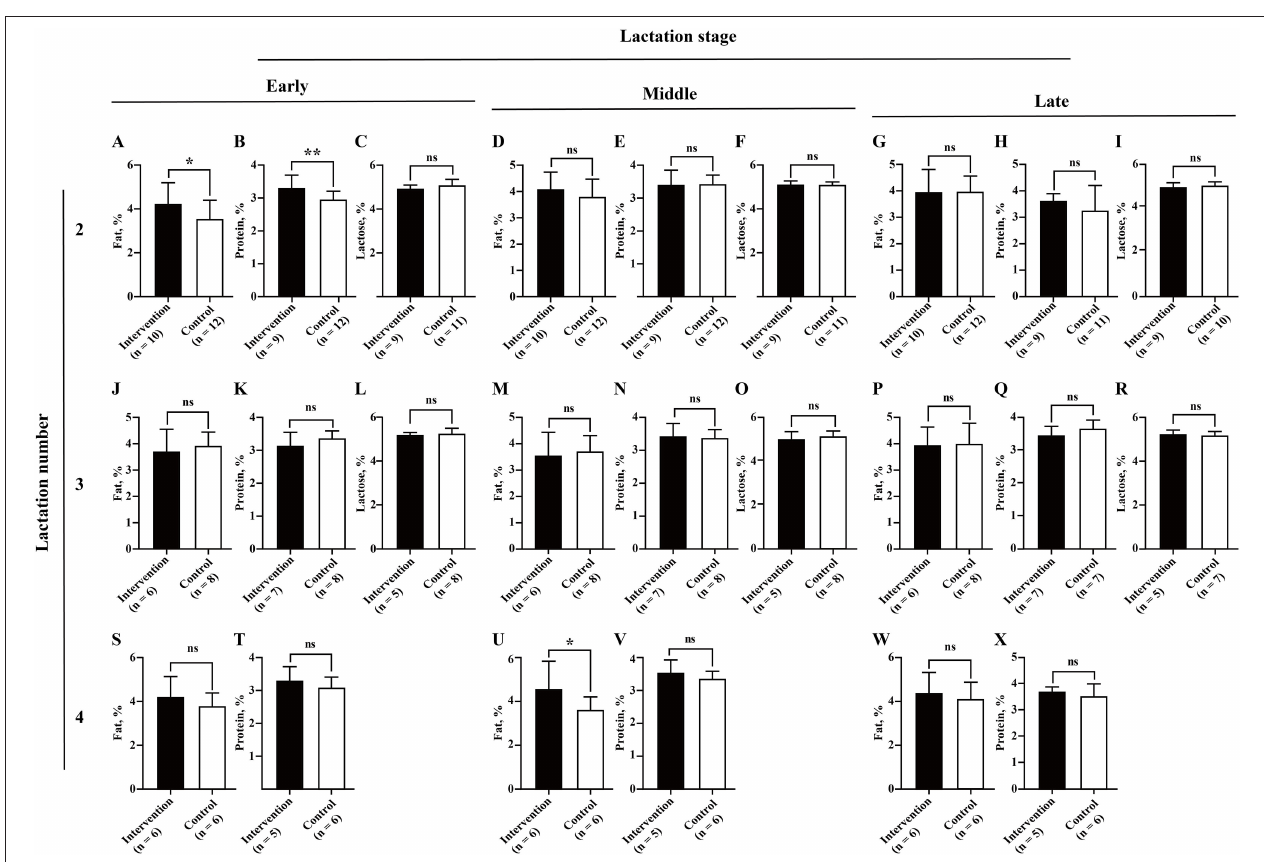
FIGURE 6 | Association between BLV infection and milk composition (fat, protein, and lactose). Average monthly milk fat (A,D,G,J,M,P,S,U,W) , protein (B,E,H,K,N,Q,T,V,X) , and lactose (C,F,I,L,O,R) for each of three lactation numbers (2, 3, and 4) and stages (early, middle, and late) were compared between the intervention (in black) and control (in white) groups by Student’s t -test. Data are shown as mean ± SD, and the symbols indicate P ≤ 0.050 (*) and P > 0.050 (ns),